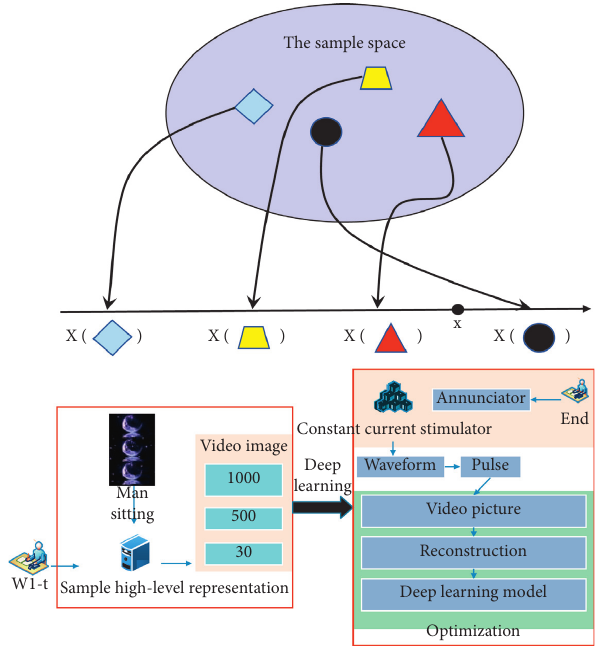
Figure 1: The operating process of image